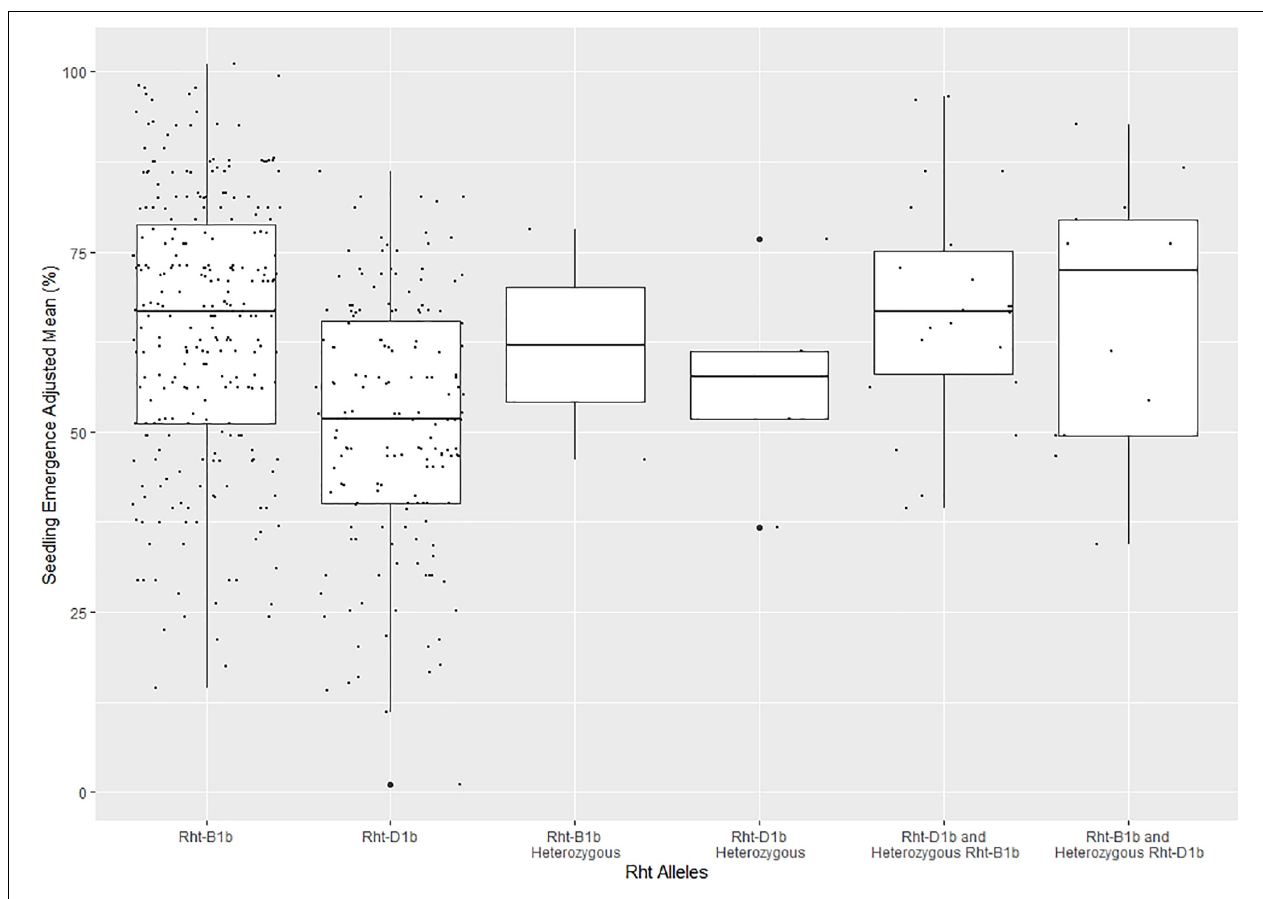
FIGURE 3 | Effect of Rht allele frequency on seedling emergence in the diversity panel varieties across the combined years of 2015–2019. The Rht markers were coded as lines with Rht-B1b, Rht-D1b, Rht-B1b heterozygous, Rht-D1b heterozygous, Rht-D1b with a heterozygous Rht-B1b, Rht-B1b with a heterozygous Rht-D1b, and both Rht-B1b and Rht-D1b heterozygous. TABLE 4 | Significant markers for coleoptile length in a Pacific Northwest winter wheat diversity panel using Bayesian information and linkage-disequilibrium iteratively nested keyway (BLINK), fixed and random model circulating probability unification (FarmCPU), and mixed linear (ML) genome-wide association study (GWAS) models.